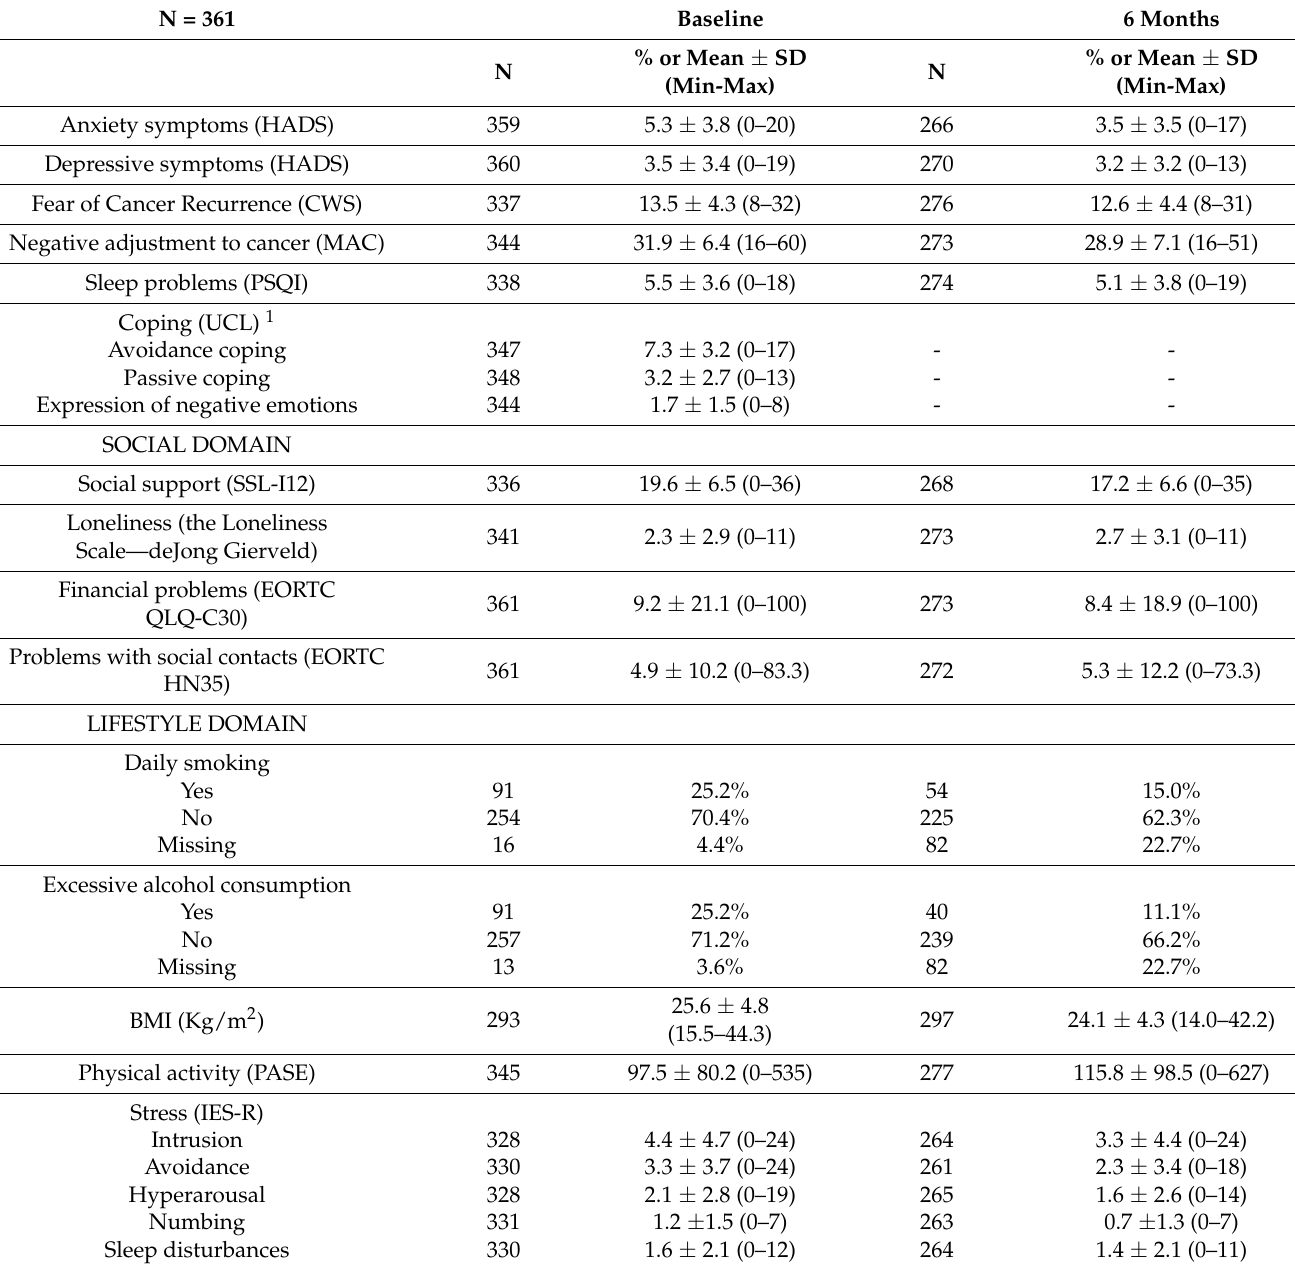
1 Missing measurements at 6 months by study design. Abbreviations: NEO-FFI = NEO Five Factor Inventory. SWAL-QoL = Swallowing Quality of Life questionnaire. FROG = Functional Rehabilitation Outcomes Grade. MNA = Mini nutritional Assessment. WHO = World Health Organization. MFI = Multidimensional Fatigue Inven- tory. IADL = Instrumental Activities of Daily Living. CFQ = Cognitive Failure Questionnaire. HADS = Hospital Anxiety and Depression Scale. PSQI = Pittsburgh Sleep Quality Index. MAC = Mental Adjustment to Cancer. UCL = Utrecht Coping List. PSMS = Pearlin and Schooler’s Sense of Mastery Scale. GSE = General Self = Efficacy Scale. BMI = Body Mass Index. PASE = Physical Activity Scale for the Elderly. IES-R = Impact of Event Scale- Revised. SSL = Social support Social Support List—Interactions. EORTC HN35 = European Organization